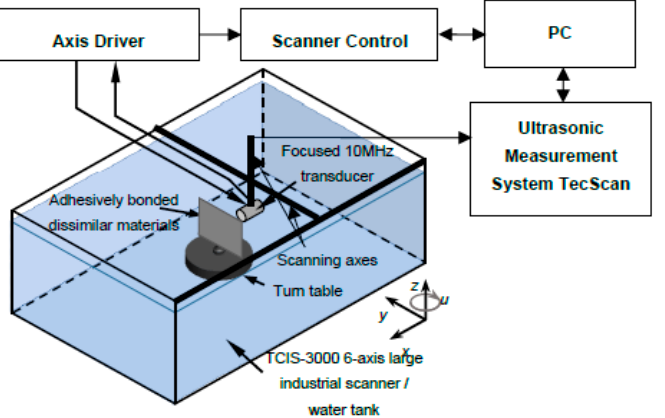
Figure 10. Ultrasonic pulse echo inspection set-up of a single-lap joint of adhesively bonded dissimilar materials.